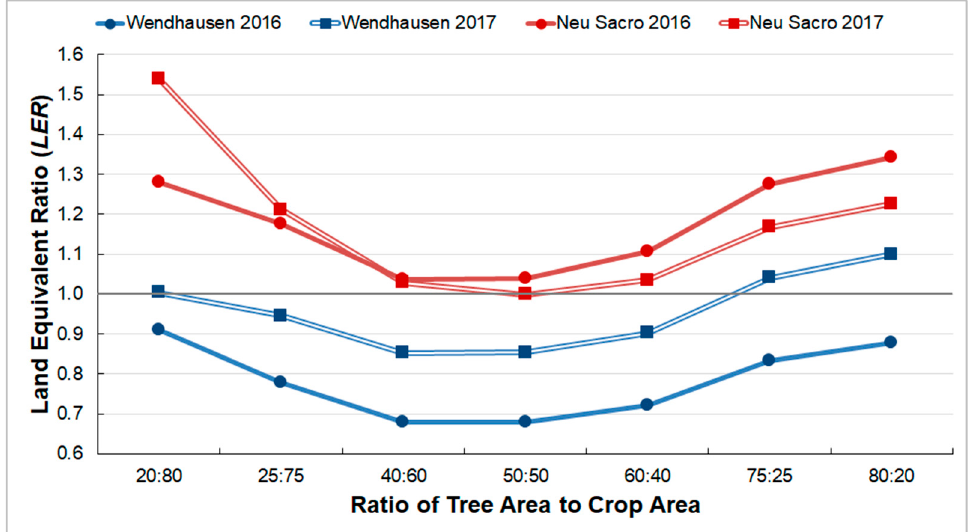
Figure 7. The effect of different ratios of tree area to crop area on the land equivalent ratio (LER), as simulated by the Yield-SAFE model for the ACSs at Wendhausen and Neu Sacro, in 2016 and 2017. The grey line serves as a threshold above which the alley-cropping system has a greater productivity than the monoculture system.